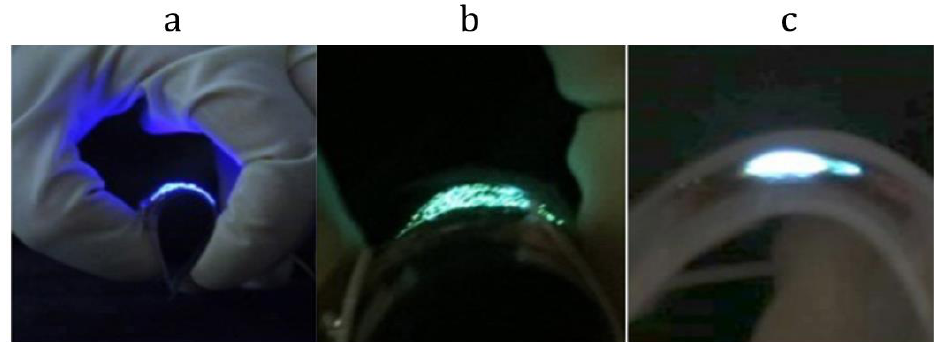
Figure 1. Optical images of operating flexible blue ( a ), green ( b ), and white ( c ) Sylgard/InGaN NW LEDs [34,40,58]. LEDs